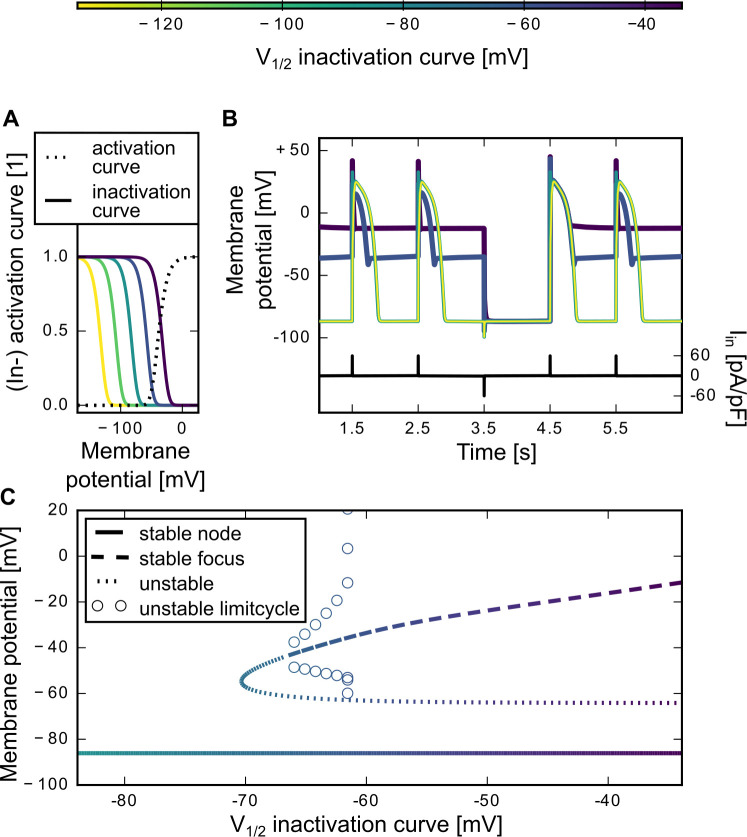
Shifting the sodium channel inactivation curve.(A) We shifted the midpoint voltage (V1/2) of the sodium channel inactivation curve from its original value at -83.9 mV in both directions: by +50 mV to more positive and -50mV to more negative voltages. The sodium channel activation curve remained unchanged. The activation and inactivation curves were based on the steady state values of the sodium activation and inactivation gate variables m, h and j (activation curve = m∞3, inactivation curve = h∞j∞). (B) Every shift of the sodium channel inactivation curve changed the cardiac action potential shape. The colors match the corresponding inactivation curve in A. The plot shows a part of a simulation with a stimulation pulse once every second (pulse length l = 2 ms, period P = 1 s, time delay t0 = 0.5 s). Pulse amplitude was always 60pA/pF (A = +60 pA/pF), just at t = 3.5 s the strength was reverted in sign (A(3.5 s) = -60 pA/pF). The current trace is shown in black. (C) Bifurcation diagram depicting the resting potential of the system for positive shifts (0 mV to 50 mV) in the midpoint voltage of the sodium inactivation curve. The linestyles code for the characteristics of the eigenvalues (see Methods). The linecolor matches the corresponding midpoint voltage of the inactivation curve (x-axis), also see colorbar.